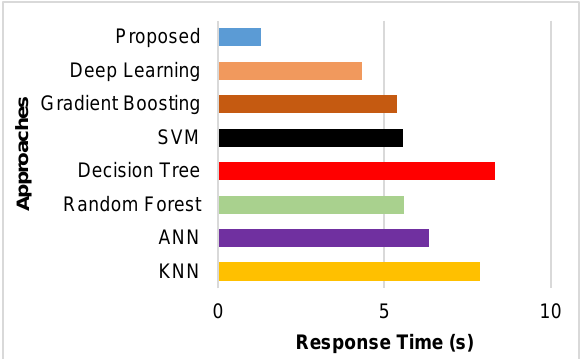
Figure 8. Comparative analysis of response time.